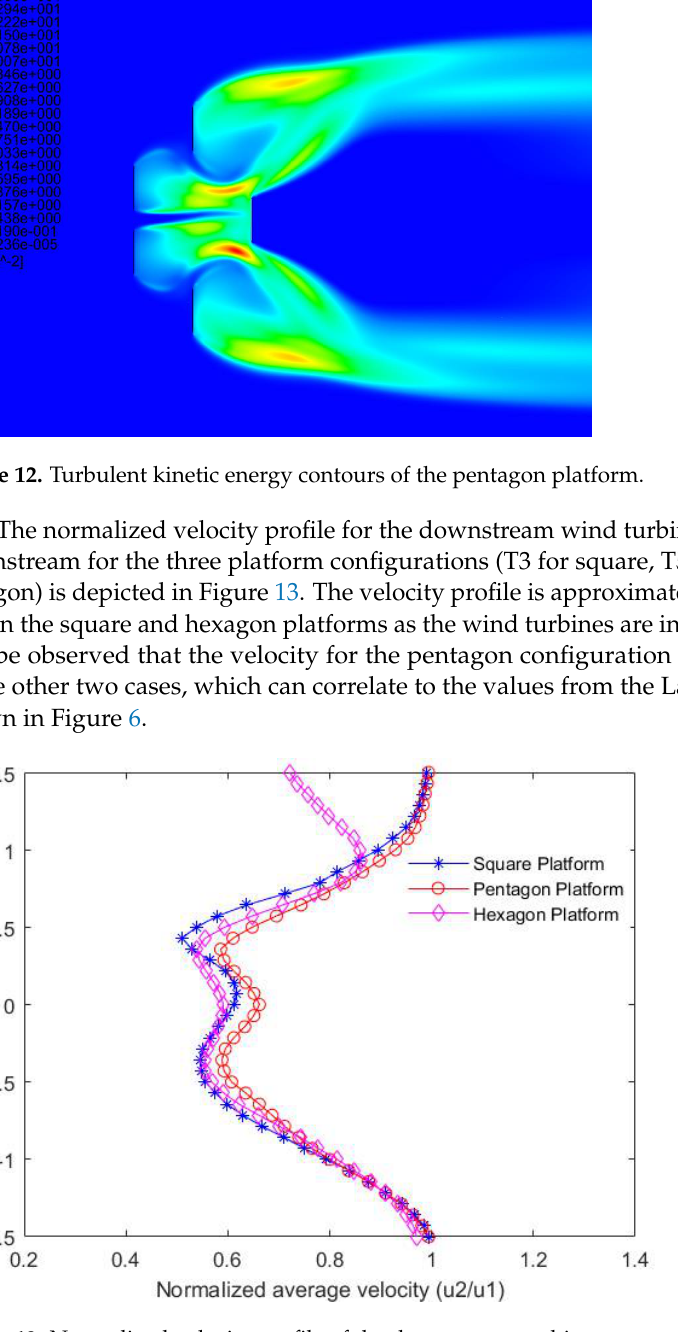
Figure 11. Velocity contours for the hexagon platform.